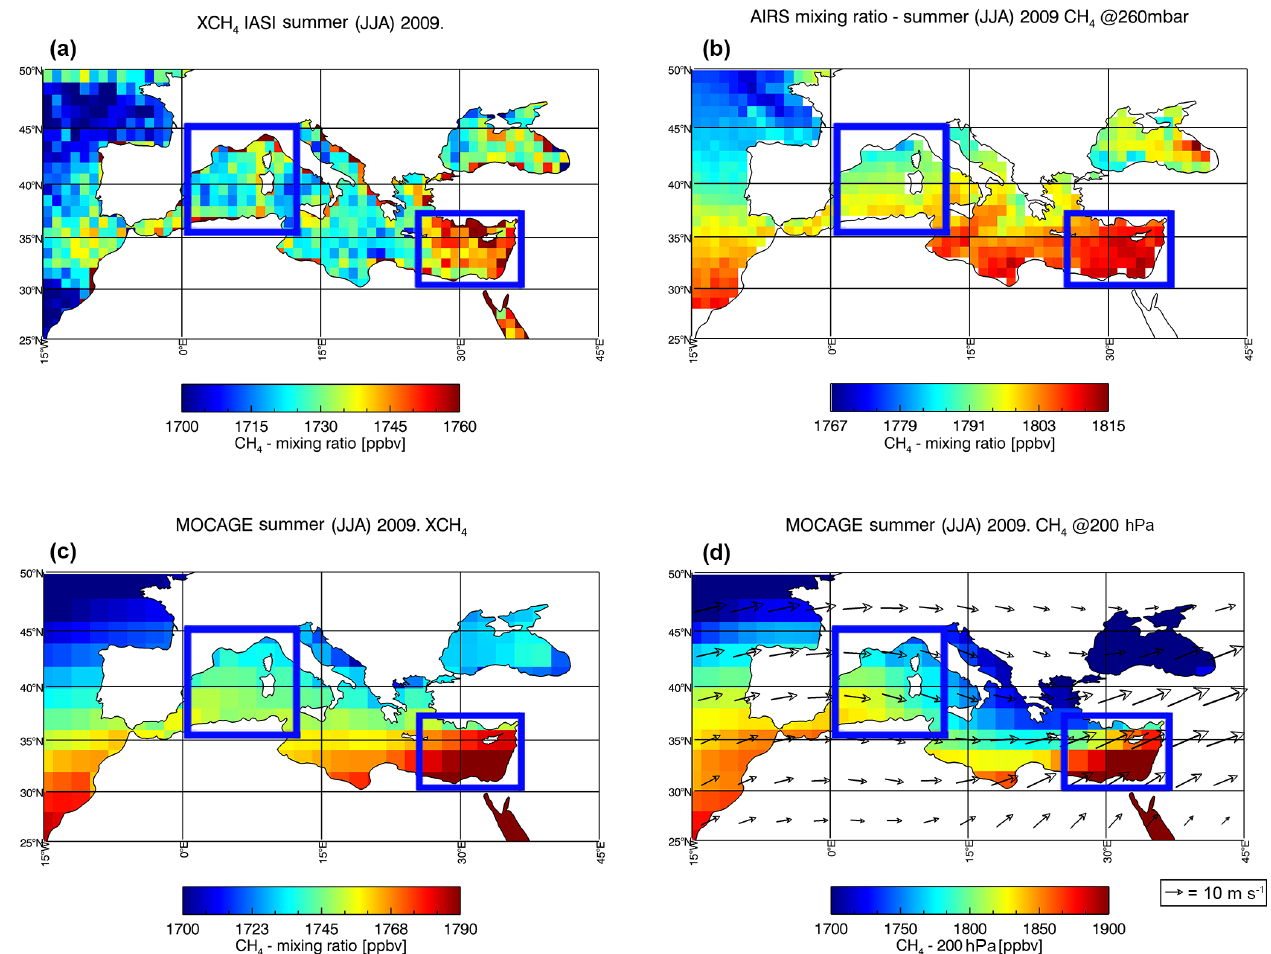
Figure 24. Fields of CH 4 as calculated by MOCAGE (c, d) and as measured by IASI (a) in total column and AIRS (b) at 260hPa averaged for summer (July, July, August) 2009. Horizontal winds are from ARPEGE averaged over the same period. The two blue squares represent the western and eastern Mediterranean basins (adapted from Ricaud et al., 2014).